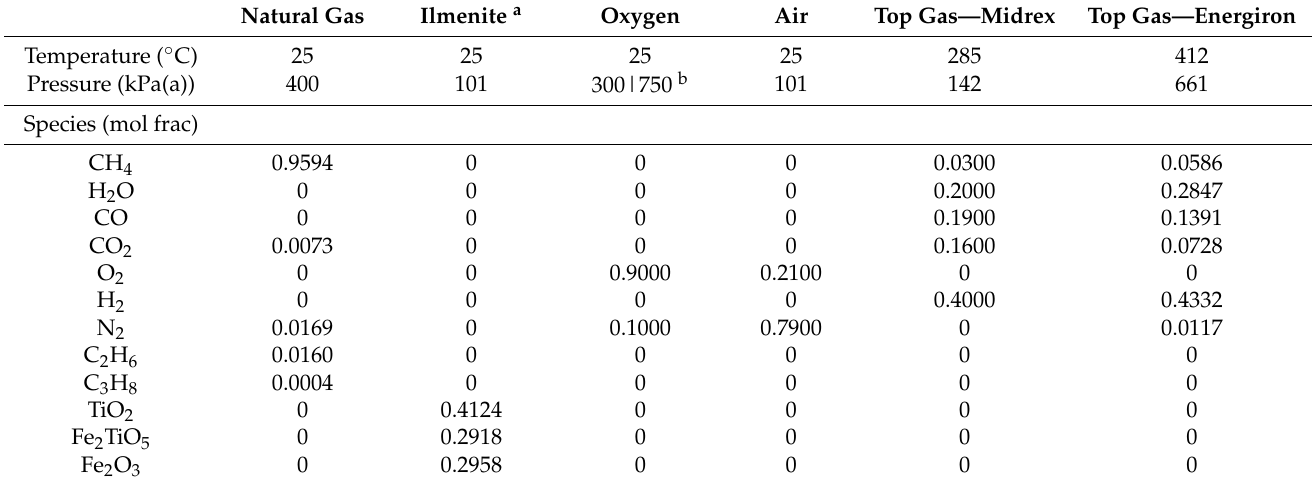
Table 2. Properties of reactants in base case and PCL-DRI process simulations.